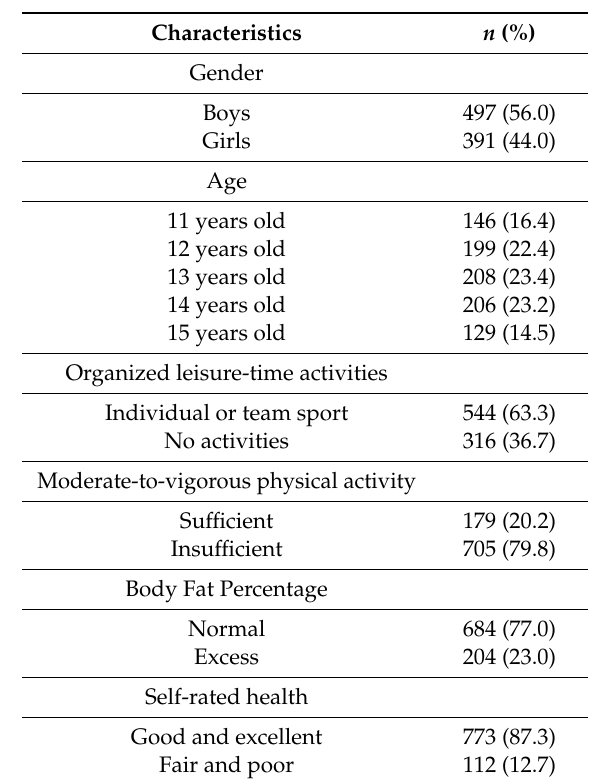
Table 1. Description of the